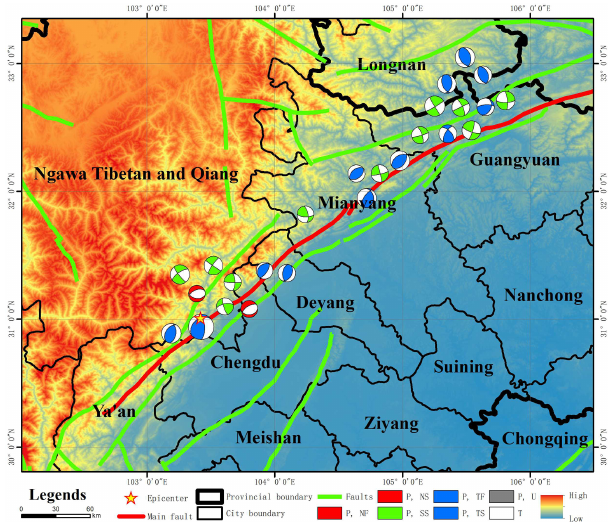
Figure 5. Structural background map of the Wenchuan earthquake. The red and green lines represent the fault structures in this area. The red line is the main fault zone of the Wenchuan earthquake, and the green lines represent other fault zones. The focal mecha- nism of the main aftershocks are also shown. Ngawa Tibetan and Qiang: Ngawa Tibetan and Qiang Autonomous Prefecture. P, T, NF, NS, SS, TF, TS and U represent tension axis, pressure axis, normal fault, strike-slip normal fault, strike-slip fault, reverse fault, strike- slip reverse fault and unknown type fault,